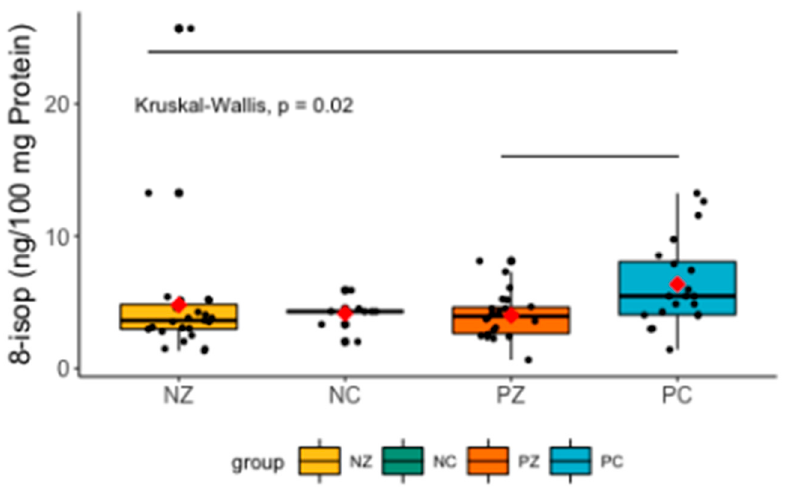
Figure 10. Levels of 8-isop in the saliva of the examined women. 8-isop, concentration of 8-isoprostane; NZ, generally healthy patients without the BRCA1 mutation; NC, patients with breast cancer but without the BRCA1 mutation; PZ, generally healthy patients with the BRCA1 mutation; PC, patients with both breast cancer and the BRCA1 mutation.